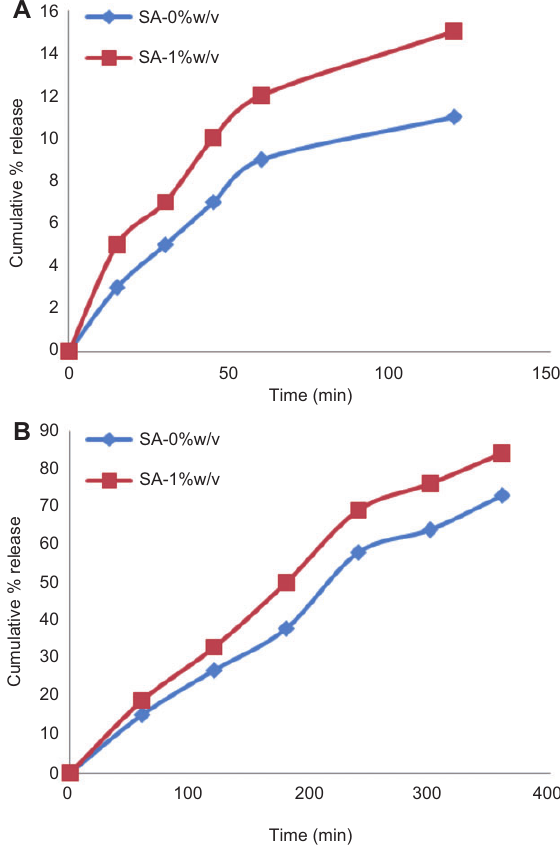
Figure 2 Release profiles of aspirin-loaded ethyl cellulose micro- particles: variation of ethyl cellulose (A) in pH 1.2 acid solutions and (B) in pH 7.4 PB solutions.